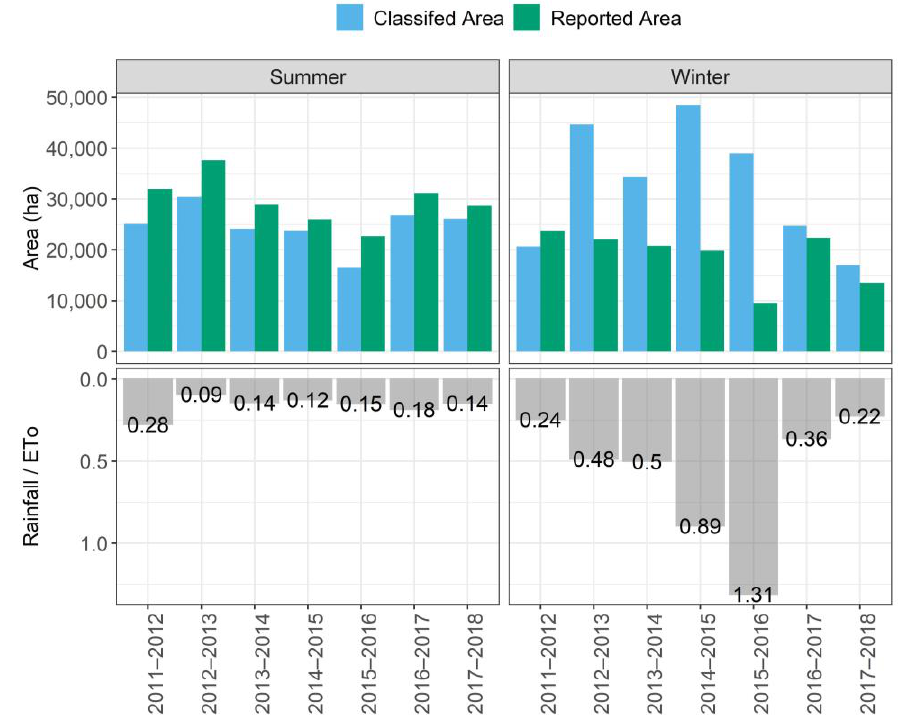
Figure 10. The classified irrigated areas (unit: ha) and their comparisons with the farmer-reported areas. The ratio of rainfall over the ETo was presented as a weather indicator, showing the crop water availability and irrigation requirement in each season.